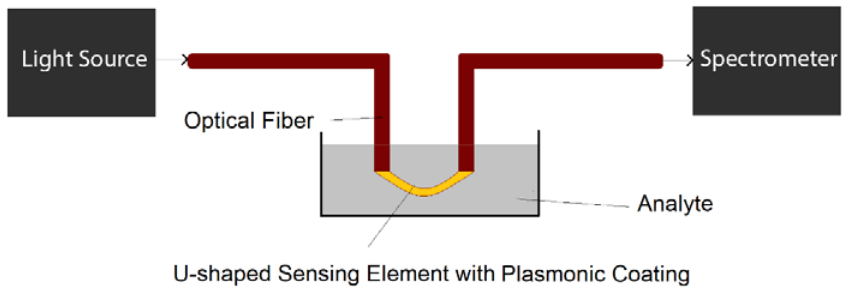
Figure 9. The schematic of a potential biosensing setup based on U-shaped plasmonic optical fibers.